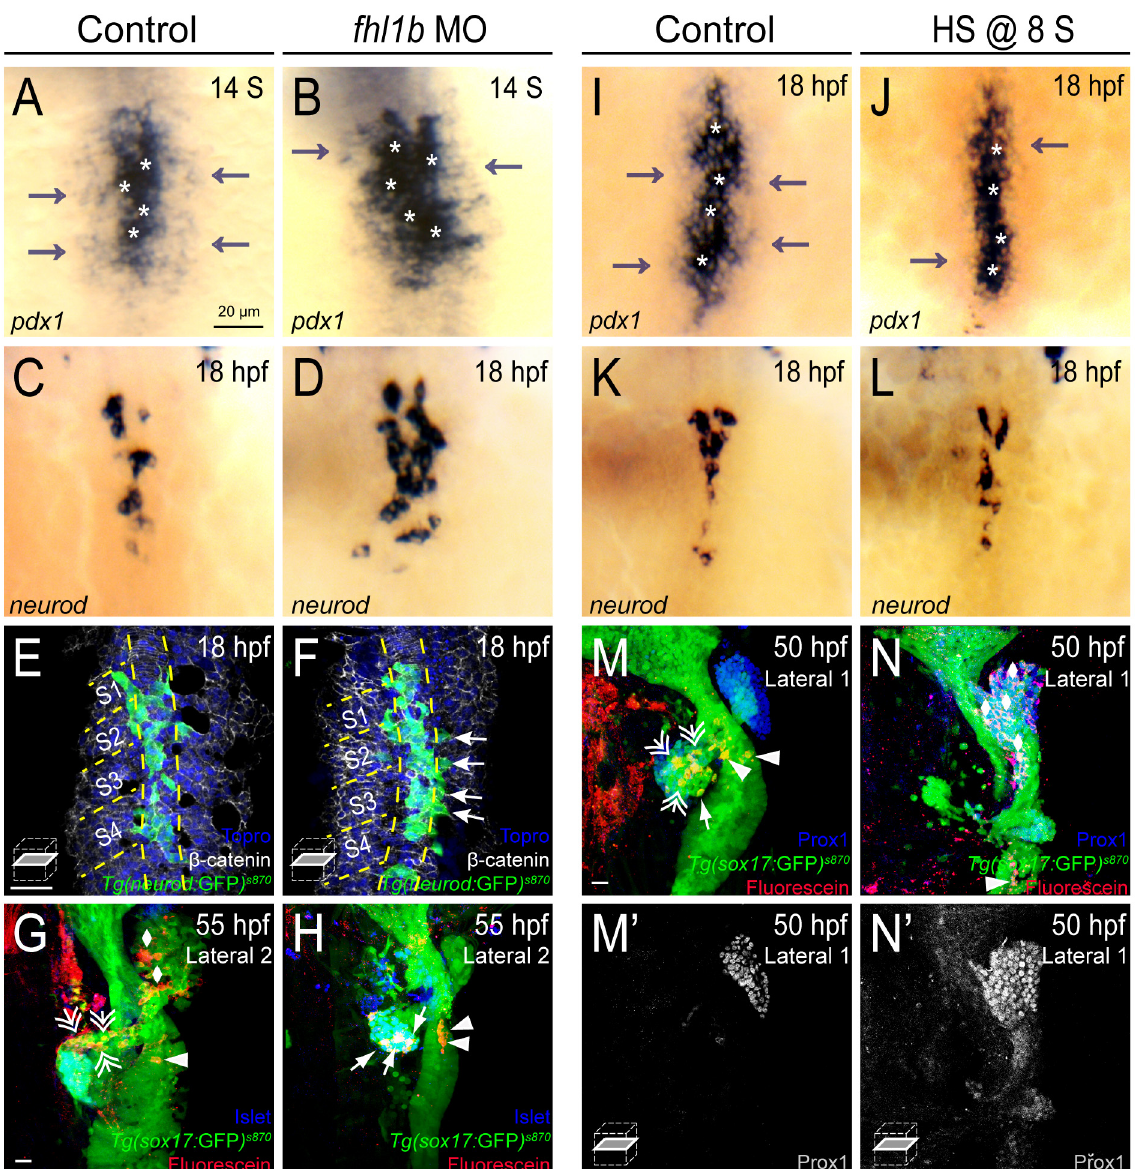
Fig 5. Fhl1b regulates the patterning and subsequent fate of the medial and lateral endodermal progenitors. (A-D) Whole-mount in situ hybridization showing the expression of pdx1 (A and B) and neurod (C and D), comparing that of control embryos (A and C) and fhl1b morphants (B and D) at the 14-somite stage (A and B) and 18 hpf (C and D). pdx1 is expressed at high levels in the most medial cells (white asterisks) and at low levels in the lateral cells (gray arrows). neurod is expressed in the high-level pdx1 -expressing cells. In fhl1b morphants, high levels of pdx1 (white asterisks) and neurod expression were expanded laterally (B and D). (E-F) Ventral confocal images showing TgBAC(neurod :EGFP ) nl1 , β -catenin (white), and Topro (blue) at 18 hpf (the notochord is outlined by yellow dashed lines). Somites are numbered from anterior to posterior (S1-S4). (E) In control embryos, TgBAC(neurod :EGFP ) nl1 - expressing cells are located close to the notochord. (F) Ectopic TgBAC(neurod :EGFP ) nl1 -expressing cells were found in lateral endodermal regions in fhl1b morphants (white arrows). (G and H) Confocal images of Tg(sox17 : GFP) s870 embryos at 55 hpf, stained for uncaged-Fluorescein (red) and Islet (blue). In control embryos (G), lateral 2 (L2) cells gave rise to the liver (white rhombi), intestine (white arrowhead), and exocrine pancreas (white double arrows), but rarely gave rise to the endocrine pancreas. In fhl1b morphants (H), L2 cells contributed to the Islet-positive pancreatic endocrine cells (white arrows), but not to the liver or exocrine pancreas. (I-L) Whole-mount in situ hybridization showing the expression of pdx1 (I and J) and neurod (K and L) at 18 hpf, comparing control embryos (I and K) and fhl1b -overexpressing embryos (J and L, heat shock applied at the 8-somite stage). In embryos induced to overexpress fhl1b at the 8-somite stage (J and L), neurod and high levels of pdx1 expression (white asterisks in J) were maintained, while low levels of pdx1 expression (gray arrows) were reduced. (M-N ’ ) Confocal images of Tg(sox17 : GFP) s870 embryos at 50 hpf, stained for uncaged-Fluorescein (red) and Prox1 (blue in M and N; grey in M ’ and N ’ ). In control embryos (M and M ’ ), lateral 1 (L1) cells gave rise to the exocrine pancreas (white double arrows) and the intestine (white arrowheads), but not to the liver. In embryos induced to overexpress fhl1b at the 8-somite stage (N and N ’ ), L1 cells mostly contributed to the